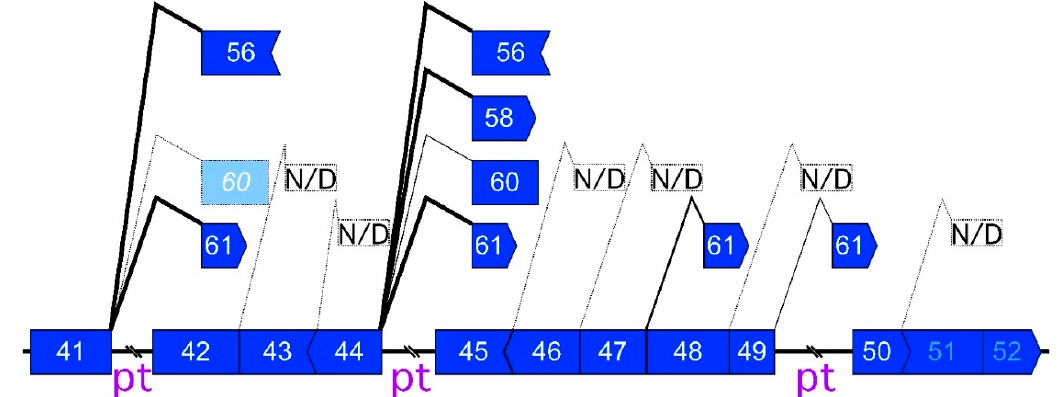
Figure 3. Multiple exon skipping (MES) around the DMD hotspot. Exon combinations of MES are shown with mountain lines on the post-transcriptional pre-mRNA, which was reported by Gazzoli et al. [28]. A broken mountain line means that a MES product was not detected (N/D), or was not validated by a hypothetical by-product, such as the exon 59–42 circRNA product (light blue). Bold lines between exons indicate post-transcriptional introns (pt), and co-transcriptional introns were eliminated between exons here. Vertical ends of blue rectangles indicate that ends of exons and codons are matched. Convex ends indicate exons containing +1 nucleotide (nt) for codons, and concave ends indicate exons showing − 1 nt. The donor site of exon 51 or 52 might be too close to detect MES products that used acceptor sites around the DMD hotspot.